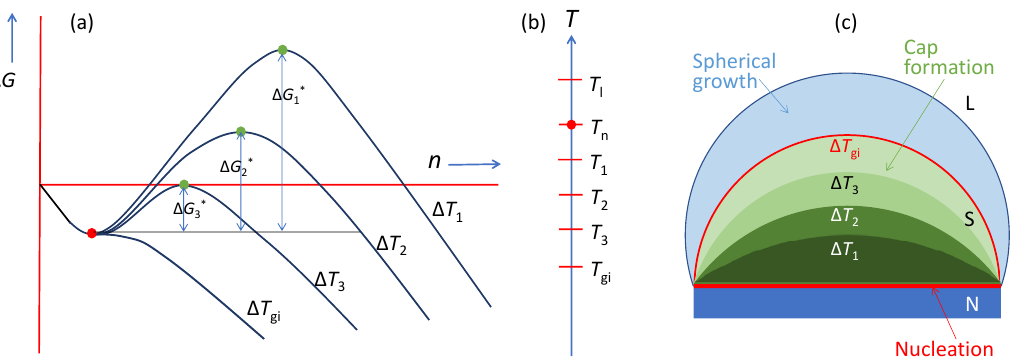
Figure 11. Schematic illustration of the constrained cap formation process. ( a ) Free energy change ( ∆ G ) as a function of the number of solid atoms ( n ) at different undercoolings ( ∆ T ); ( b ) relative position of different temperatures ( T ); and ( c ) the constrained cap formation process with decreasing temperature. The red dot marks the nucleation finishing point, and the green dots mark the maximum ∆ G which defines the energy barrier for free growth at each undercooling.